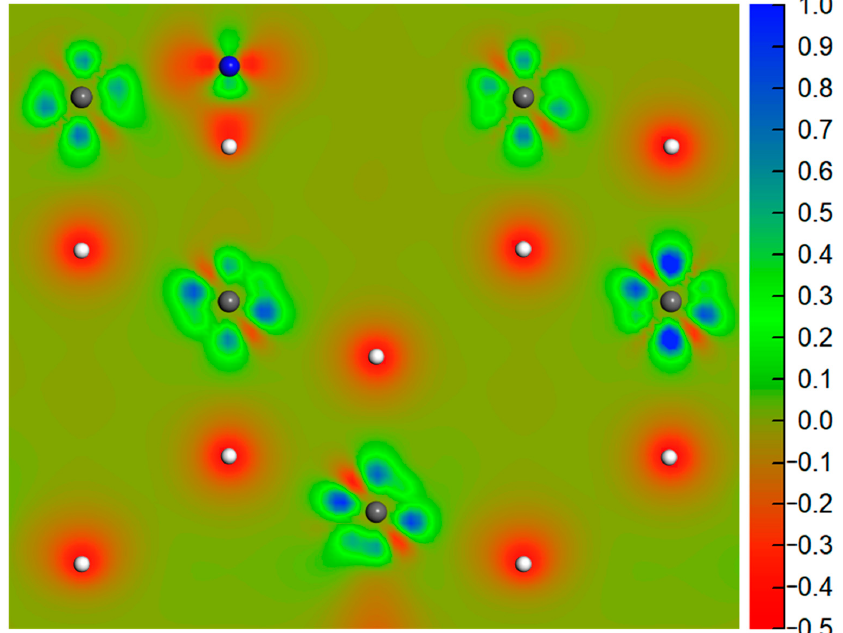
Figure 5. Charge density difference contour map along the (110) plane. The loss of electrons is indicated in blue, while electron enrichment is indicated in red. The gray, blue, and white spheres represent Pu, N, and H atoms, respectively.